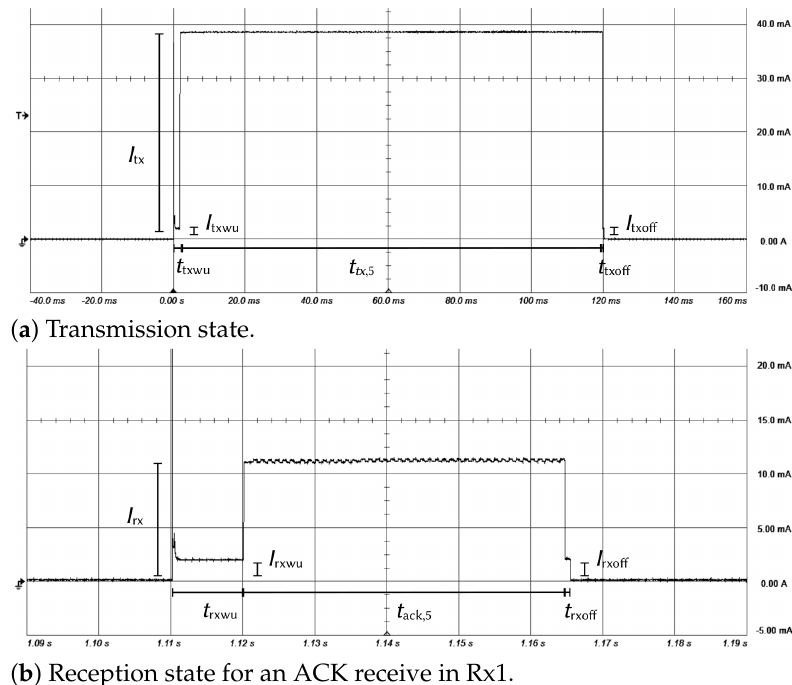
Figure 11. Measured current in transmission and reception states (DR =